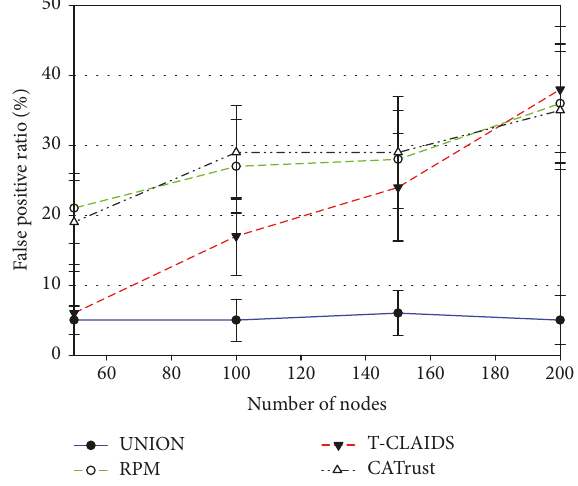
Figure 7: 𝑈𝑁𝐼𝑂𝑁 false positive ratio compared to 𝑅𝑃𝑀 , 𝐶𝐴𝑇𝑟𝑢𝑠𝑡 , and 𝑇 - 𝐶𝐿𝐴𝐼𝐷𝑆 in the presence of 25% dishonest